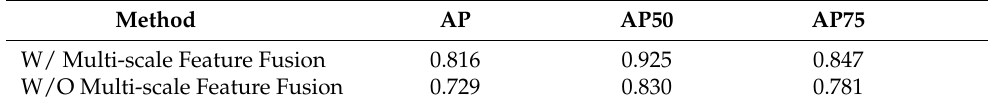
Table 4. The independent ablation experiments to verify the effectiveness of multi-scale feature